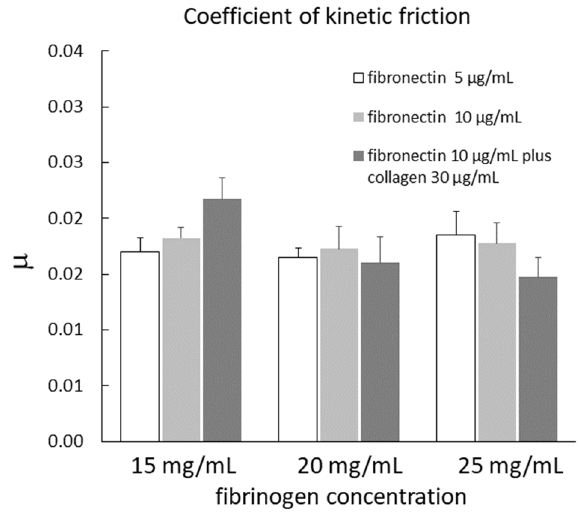
Figure 2. Coefficient of kinetic friction ( μ ) of cells seeded on different gels with different coatings. Data are means of four measurements for each type of substrate.